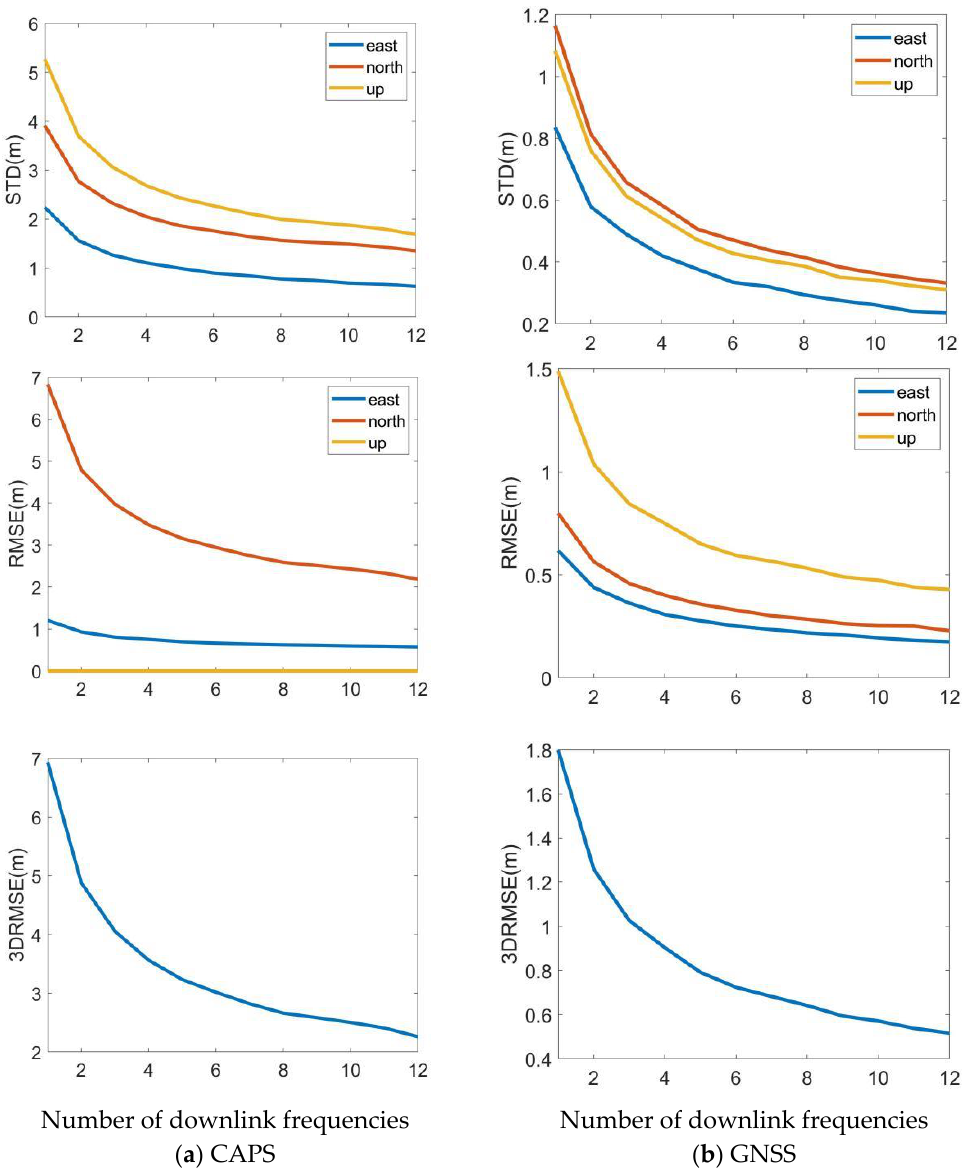
Figure 8. Positioning precision and improvement of multi-frequency navigation signals in CAPS system and GNSS system. Subfigures ( a ) at left column are standard deviation and the root mean square error in three directions and root mean square error of three-dimensional space change with the number of downlink frequencies in CAPS system; abd subfigures ( b ) at right column are standard deviation and the root mean square error in three directions and root mean square error of three-dimensional space change with the number of downlink frequencies in GNSS system.